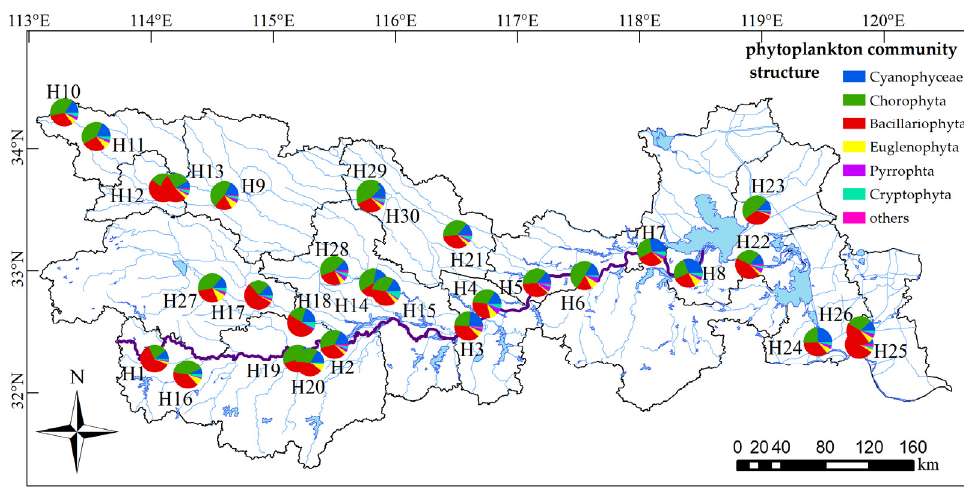
Figure 2. Composition of phytoplankton species in the Huaihe River Basin.